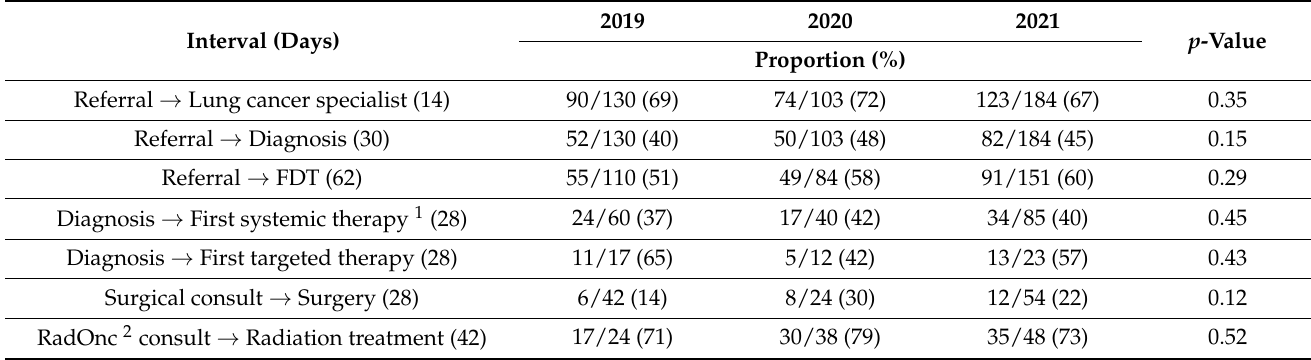
Table 7. Meeting the wait time